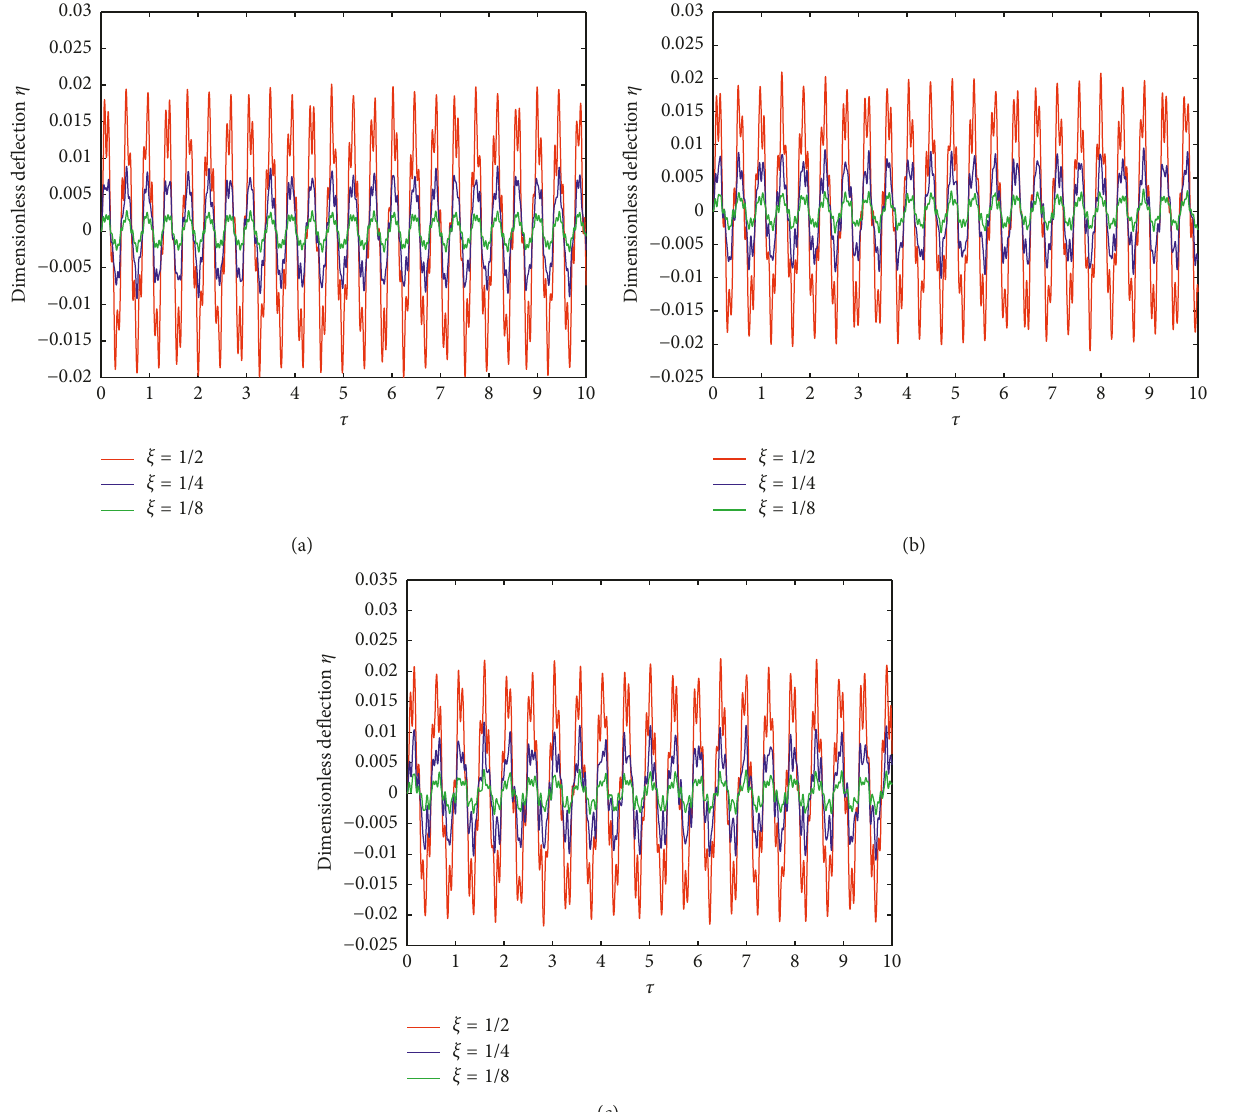
Figure 14: History curves of the deflection of the clamped-pinned pipe at different locations and having different fluid velocities: (a) u � 0; (b) u � 1; (c) u �